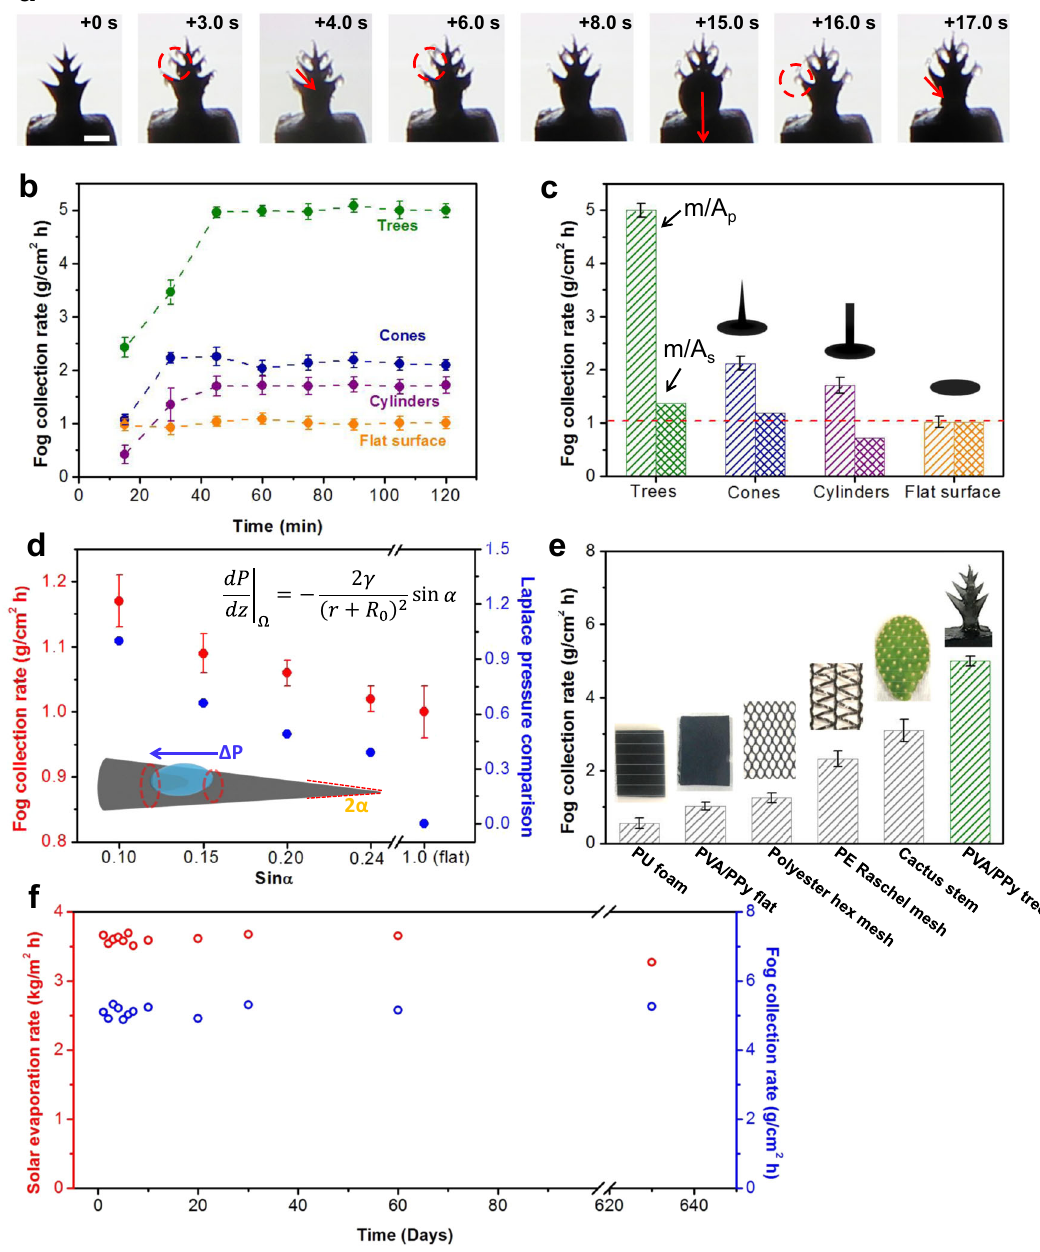
Fig. 3 Fog collection properties of PVA/PPy gel membranes with micro-tree topologies. a Snapshots of fog collection process for a single gel tree. Red circles correspond to droplet formation events and arrows point to droplet motion trajectories. Scale bar: 0.5 mm. b Fog collection rates measured for different gel membrane geometries as a function of time that demonstrates saturation at a particular time, unique to each geometry. c Fog collection rates of different gel membranes at steady states normalized by the projected area, A p , (left column) and by the total surface area, A s , (right column). d Fog collection rate and Laplace pressure difference as a function of apex angle. e Comparison to commercial meshes and a real Cactus stem. f PVA/PPy gel micro-tree array maintains dual water harvesting functions after more than twenty-month water. The membrane was fl oated on water and placed under the 4 mm thick supporting layer and found that the water evapora- light beam. The mass of the water loss was measured every 10 tion rate remained similar. min after the temperature of gel membranes achieved steady status. The PVA/PPy gel membrane with micro-tree array showed the best evaporation rate calculated per projected (illu- minated) area, A p , of 3.64 kg m − 2 h − 1 , which is 7.1 times higher than that of free water and 14.1% higher than that of gel fl at membrane (Fig. 4a). We fabricated additional hybrid gel micro- trees arrays with large areas (Supplementary Fig. 19) or with a